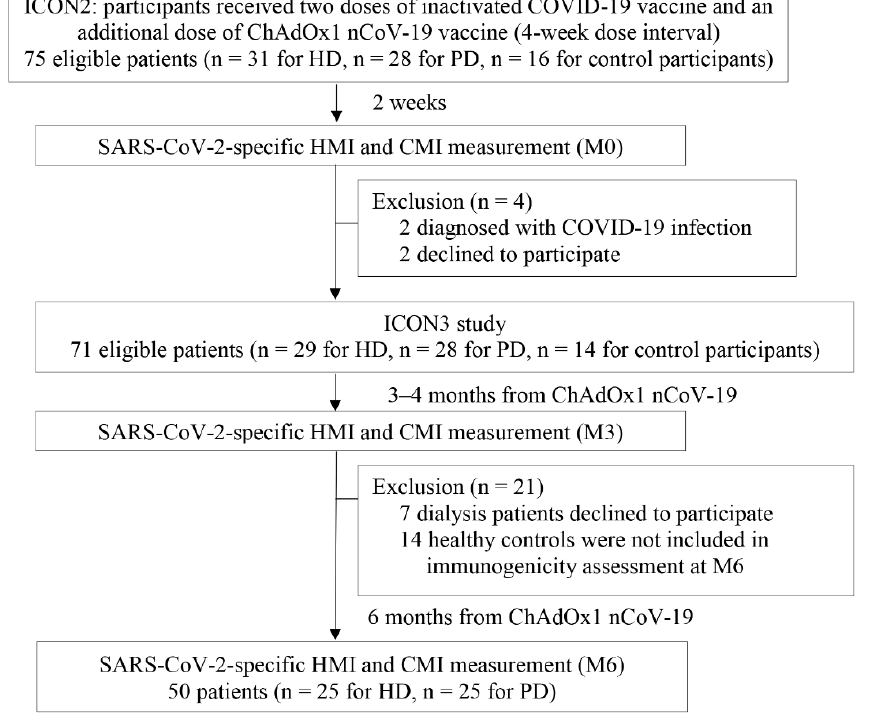
Figure 1. Study flowchart. CMI, cell-mediated immunity; COVID-19, coronavirus disease 2019; HD, hemodialyzed patients; HMI, humoral immunity; IgG, immunoglobulin G; n, number; SARS-CoV-2, severe acute respiratory syndrome coronavirus-2.